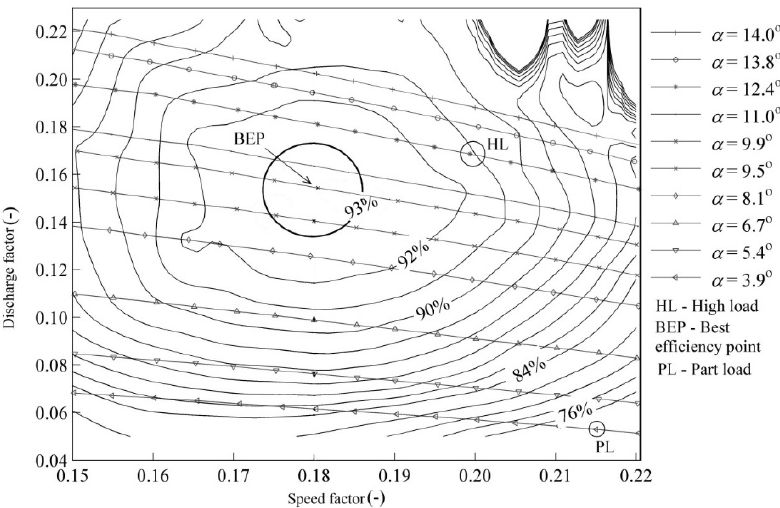
Figure 3. Constant efficiency hill diagram of the model Francis turbine ( D = 0.349 m, H =12 m); n ED = 0.18 is the dimensionless synchronous speed of the model turbine runner, BEP refers to the best efficiency point ( n ED = 0.18, and Q ED = 0.15), and α corresponds to the angular position of the guide vanes in degrees [5].